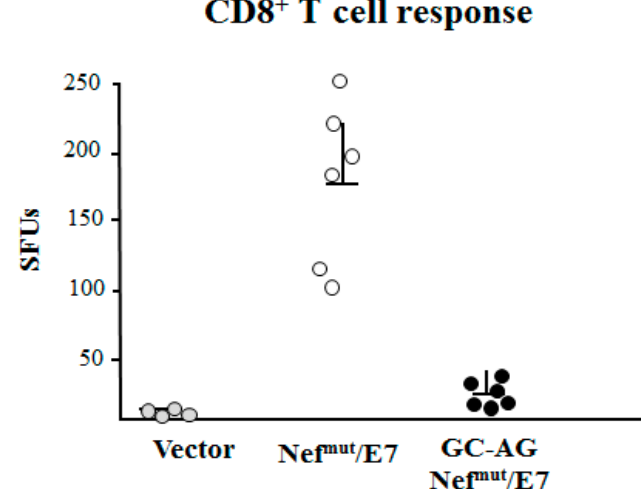
Figure 6. HPV16-E7-specific CD8 + T-cell immunity induced in mice after i.m. DNA injection. CD8 + T-cell immune response in C57 Bl / 6 mice inoculated i.m. with the DNA vectors expressing either Nef mut / E7 or GC-AG Nef mut / E7 DNA vectors. As controls, mice were inoculated with void vector. At the time of sacrifice, 2.5 × 10 5 splenocytes were incubated o.n. with or without 5 µ g / mL of either unrelated or E7-specific peptides in triplicate IFN- γ ELISpot microwells. Shown are the numbers of IFN- γ spot-forming units (SFU) / well as mean values of triplicates after subtraction of mean values measured in wells of splenocytes treated with the unspecific peptide. Reported are cumulate data from two independent experiments. Intragroup mean values + standard deviations are also reported.